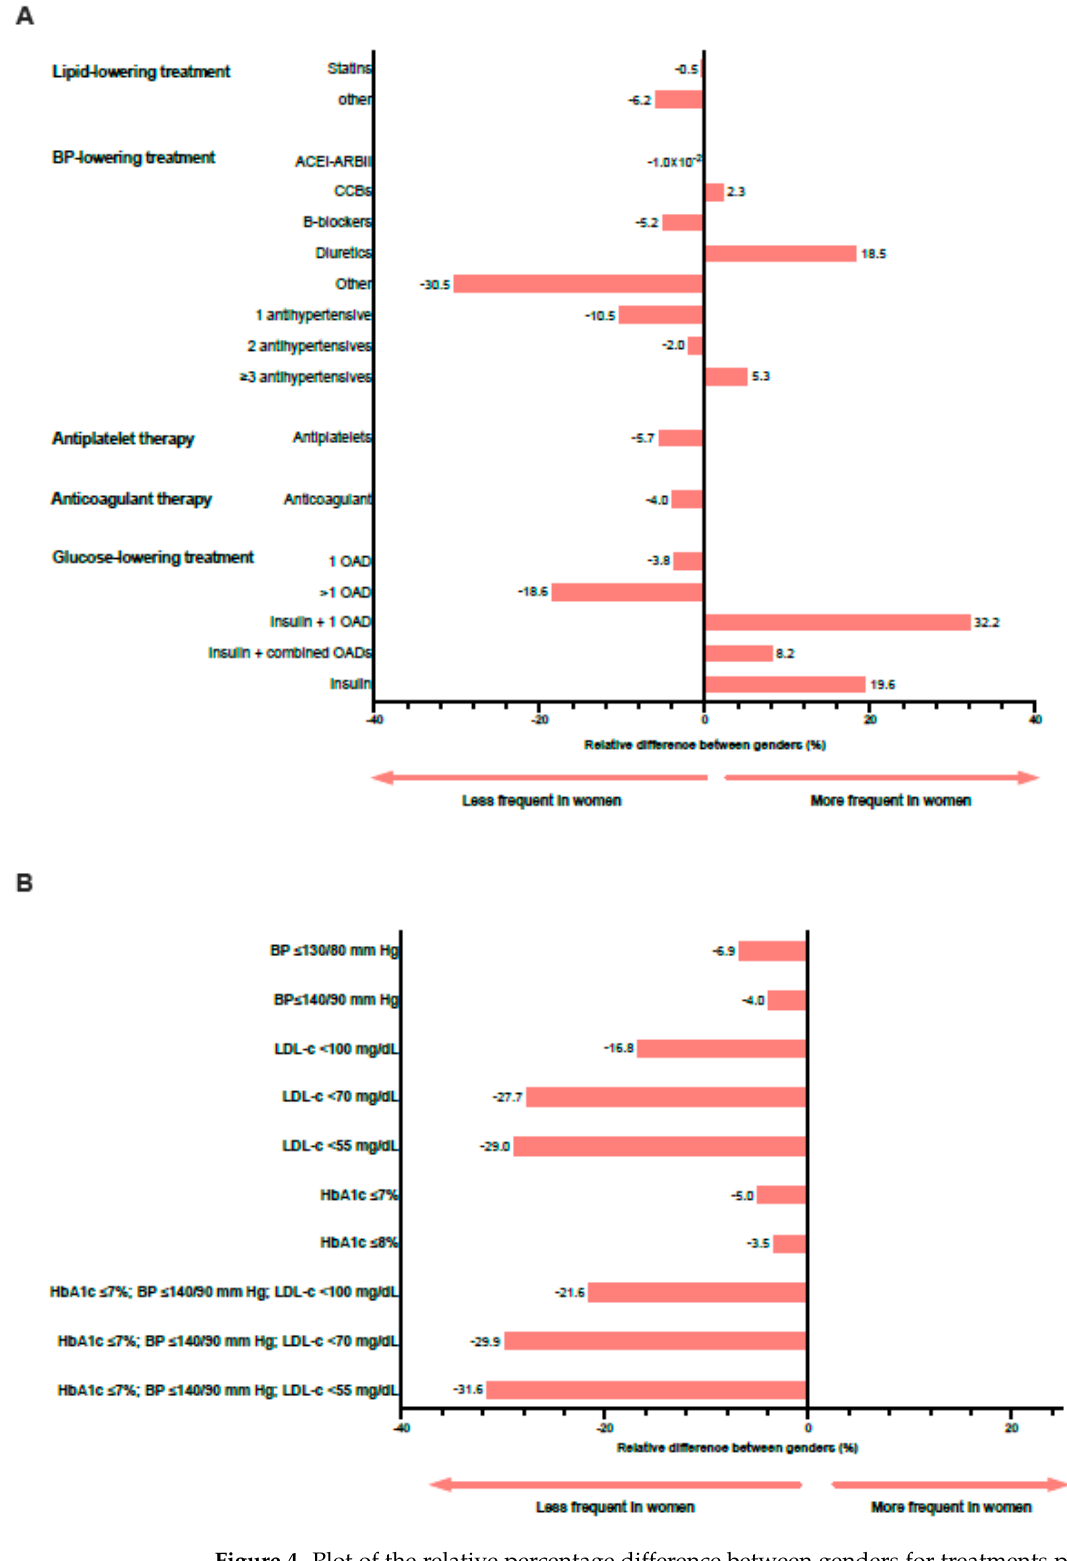
Figure 4. Plot of the relative percentage difference between genders for treatments prescribed ( A ) and target achievement ( B ) in the population in secondary prevention (ACEI/ARBII, angiotensin- converting enzyme inhibitors/angiotensin II receptor blockers; BP, blood pressure; CCB, calcium channel blockers; HbA1c, glycated hemoglobin; LDL-c, low-density lipoprotein cholesterol; OAD, oral antidiabetic drug).